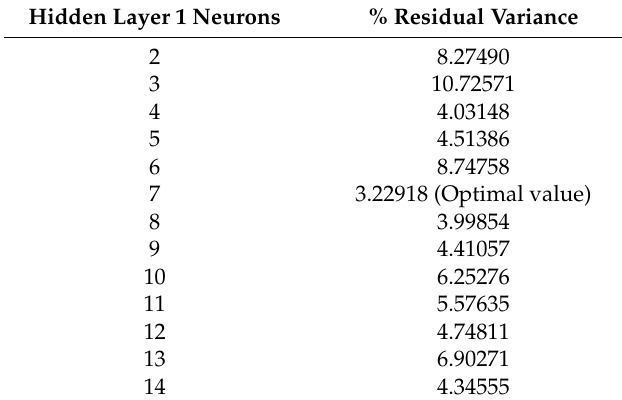
Table 1. Optimum neurons at the hidden layer.